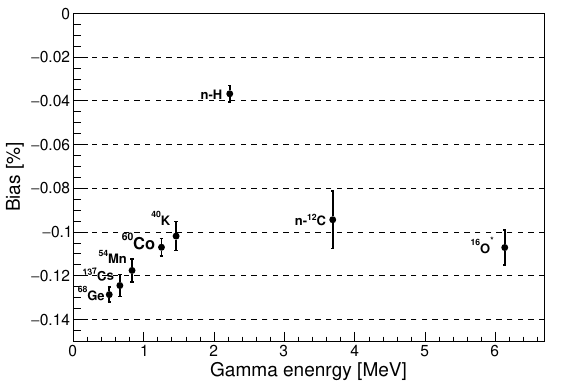
) /E ideal due to optical shadowing for individual gamma sources Figure 5 . Bias ( E shadow − E ideal vis vis vis from the source assemblies as in figure 4. The lower probability of neutron capture on carbon than that on hydrogen leads to a large statistical